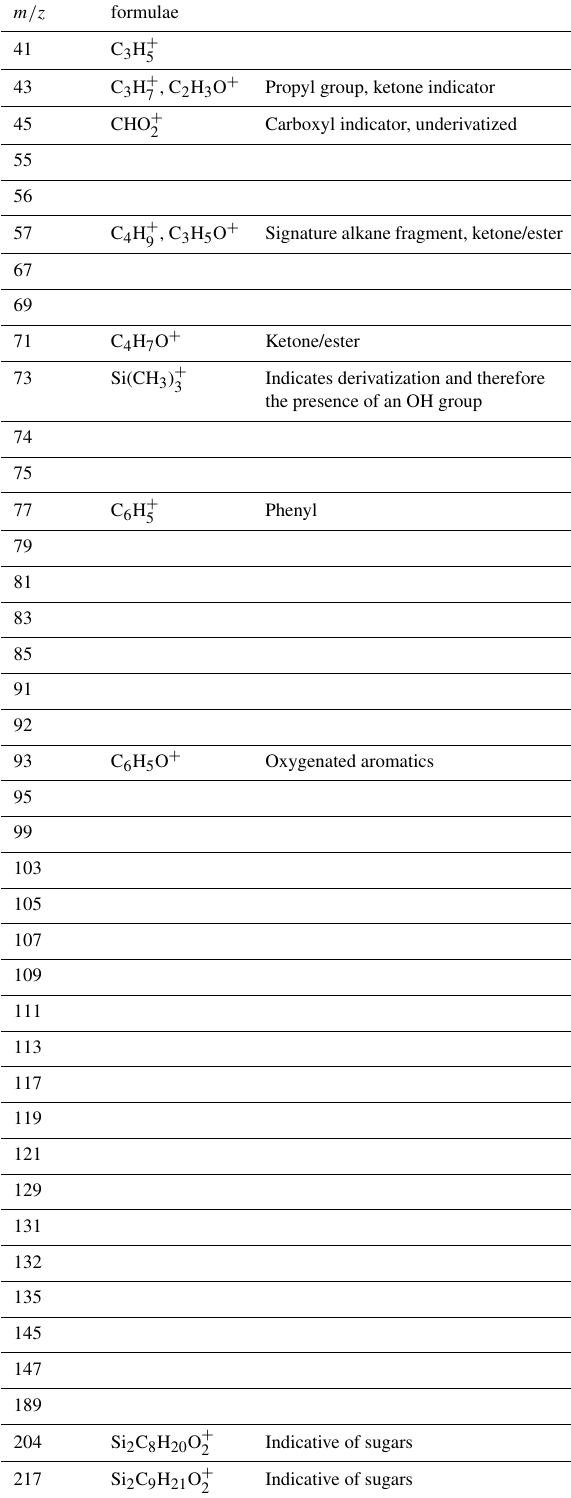
Table A2. The 40 most common charged fragments featurized for mass spectral featurization, with possible formulae and implications of published peaks.